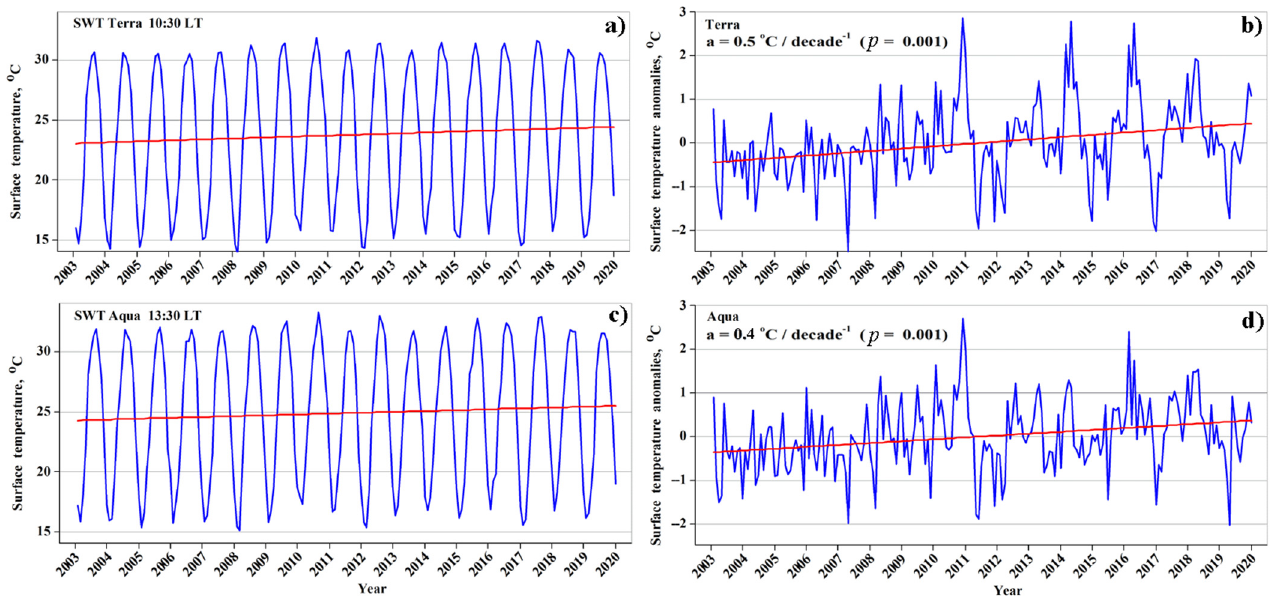
Figure 5. Monthly variations of daytime Kinneret SWT during the 17-year period under study. The left column represents original ( a ) MODIS/Terra (10:30 LT) and ( c ) MODIS/Aqua (13:30 LT) monthly data (averaged over the specified Kinneret water area), while the right column ( b , d ) represents their associated deseasonalized monthly anomalies. The straight red lines designate linear fits.